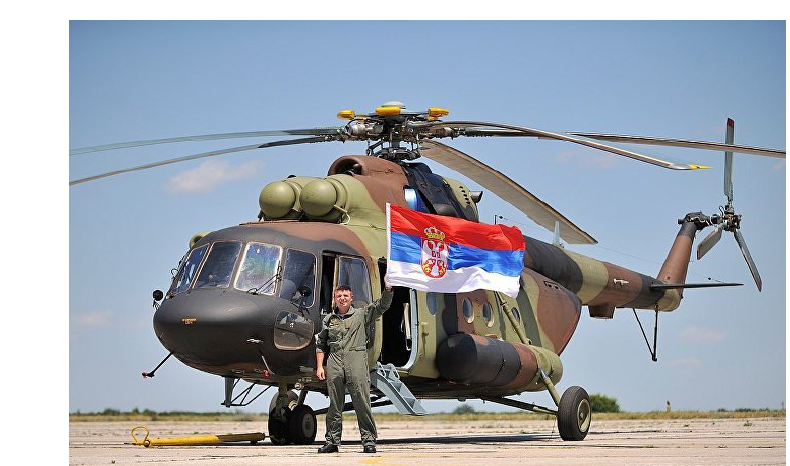
Figure 2 – Multi-purpose medium transport helicopter Mi-17V5 (Ministry of Defense of